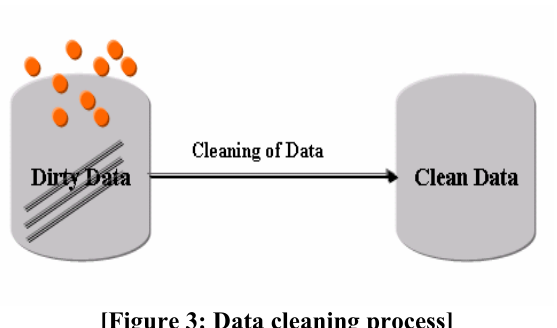
[Figure 3: Data cleaning